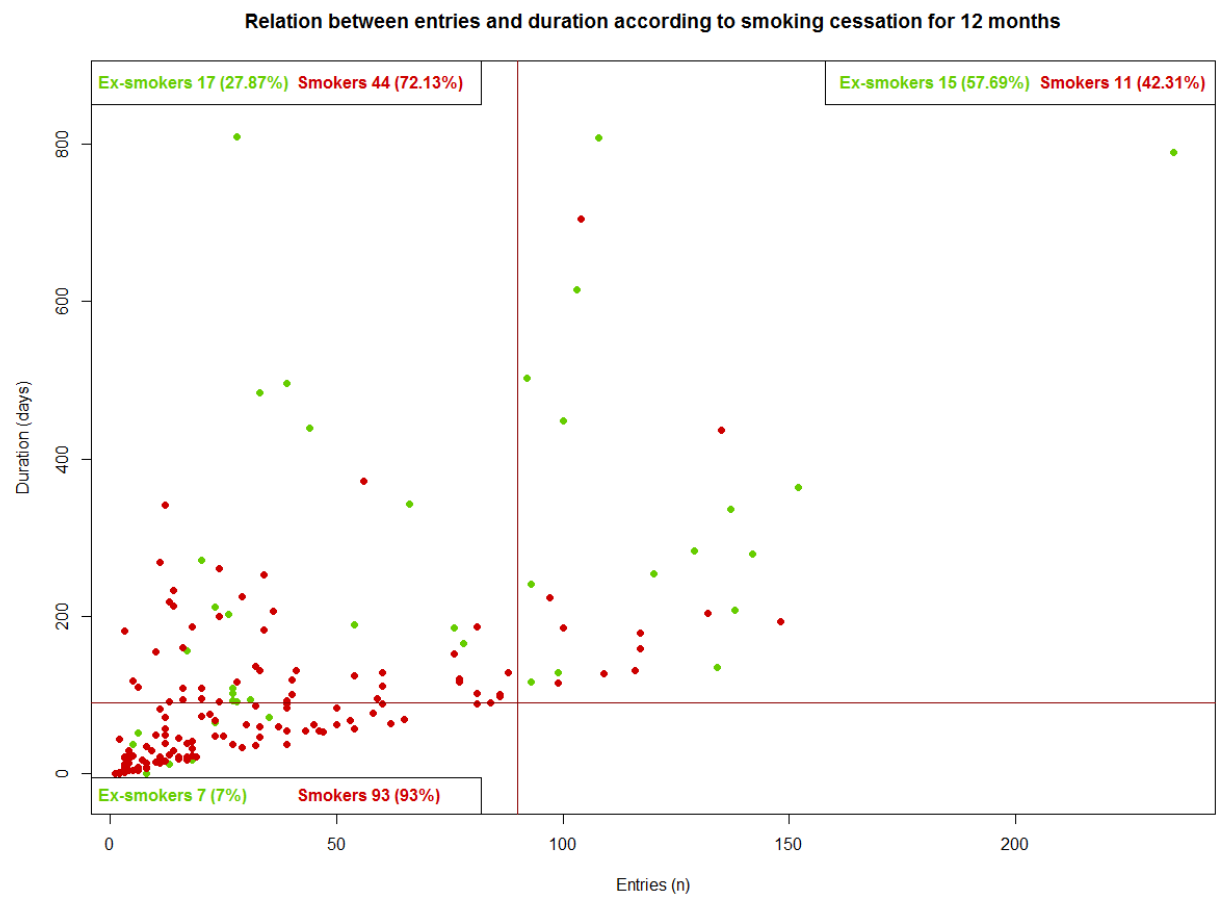
Figure 3. Relation between entries and duration accoding to smoking cessation for 12